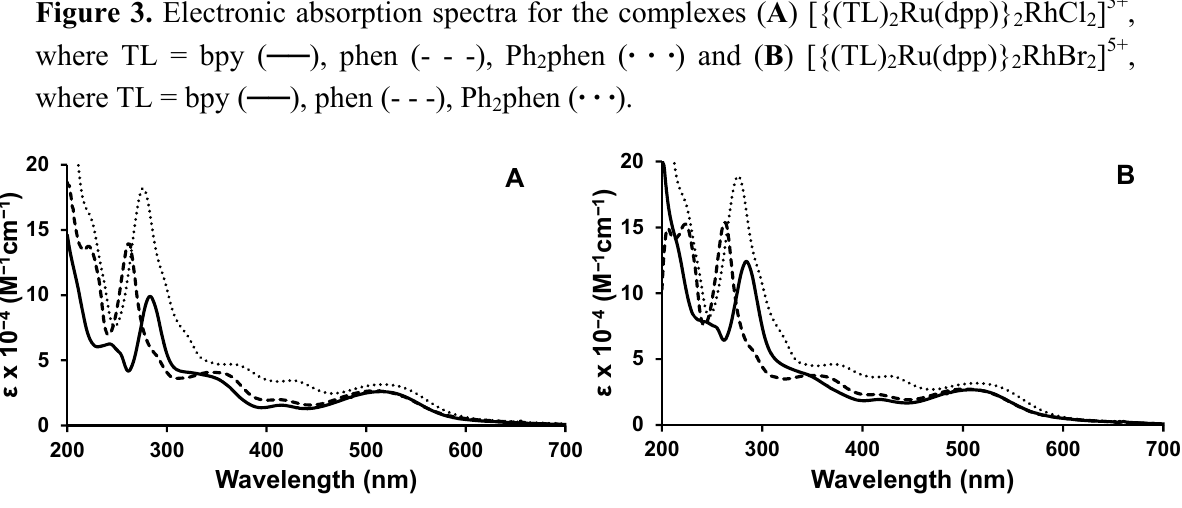
Figure 3. Electronic absorption spectra for the complexes ( A ) [{(TL) where TL = bpy ( ── ), phen (- - -), Ph